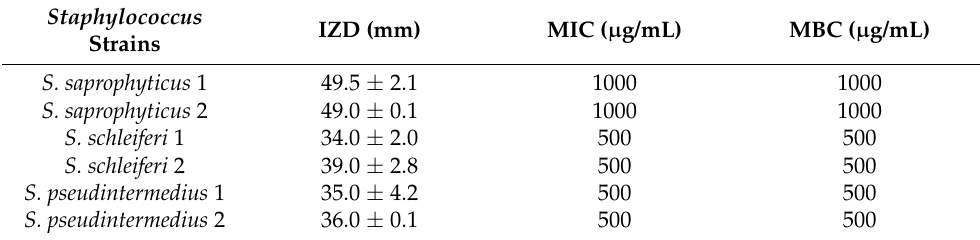
Table 2. Inhibitory zone diameter (IZD), minimum inhibitory concentration (MIC) and minimum bactericidal concentration (MBC) of the Cinnamomum zeylanicum essential oil (CZEO) for the Staphylococcus strains.